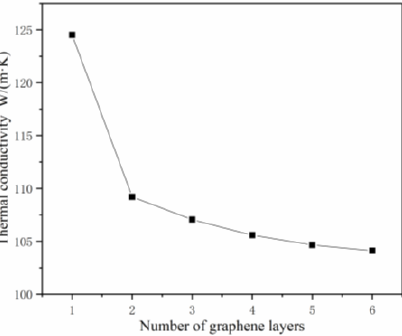
Figure 11. The K c of models of graphene with different degrees of agglomeration.